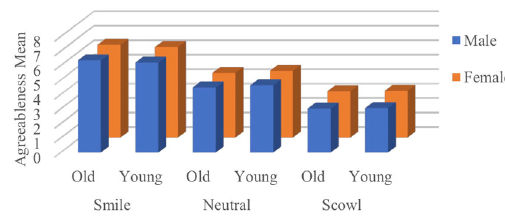
Fig. 9 Facial expression and Agreeableness. This graph presents interaction of facial expression, age, and gender on mean ratings of Agreeableness.